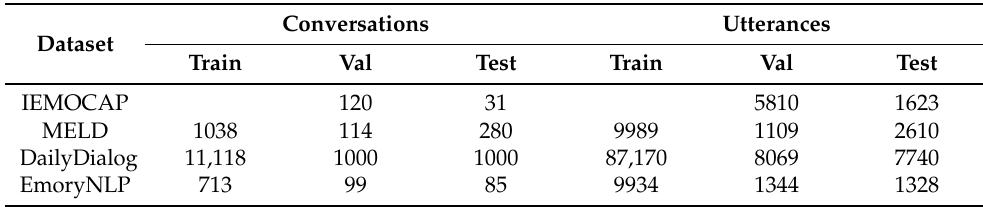
Table 2. The statistics of four